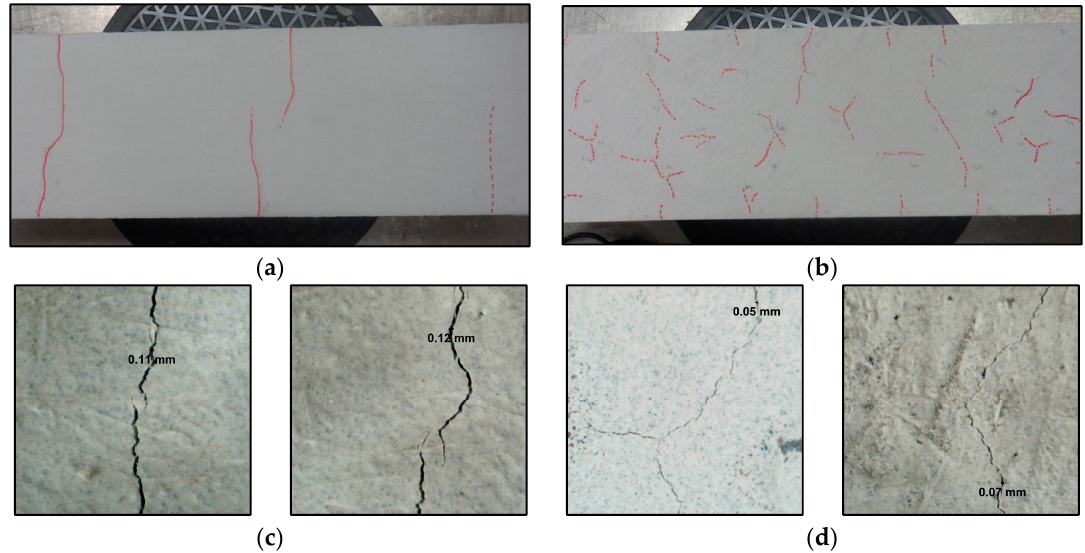
Figure 12. Experiments: Crack patterns in a commercial repair material at ( a ) low and ( c ) high magnification and in strain hardening cementitious composite (SHCC) repair material at ( b ) low and ( d ) high magnification (more results can be found in Chapter 6 in [39]).